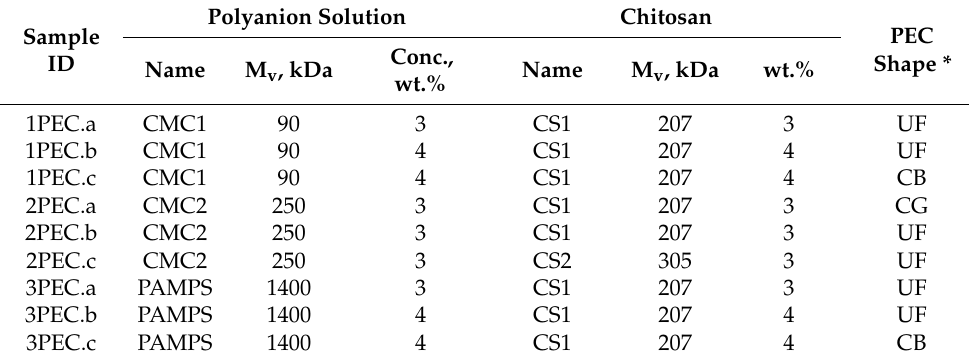
Table 1. Polyanion/CS sets used in the fabrication of PEC